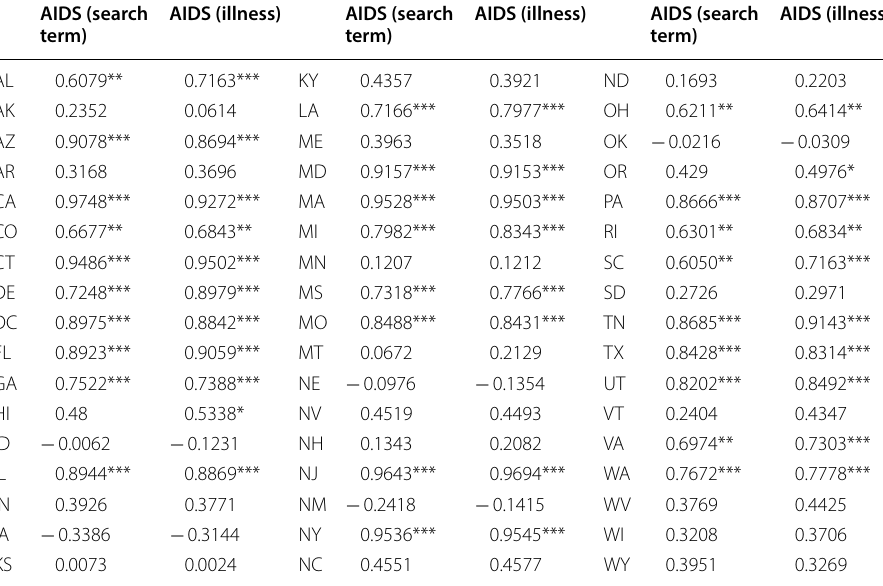
Table 3 Pearson correlation coefficients between ‘AIDS Deaths’ and (a) AIDS (Search Term)’ and (b) ‘AIDS (Illness)’ from January 2004 to December